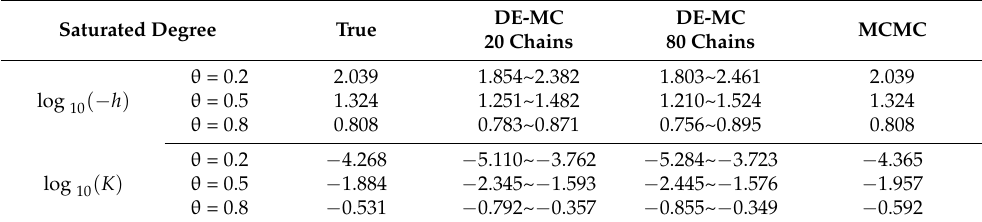
Figure 4. The SWCC and HCF of synthetic examples and true values. Table 3. The ranges of SWCC and HCF at specific saturated